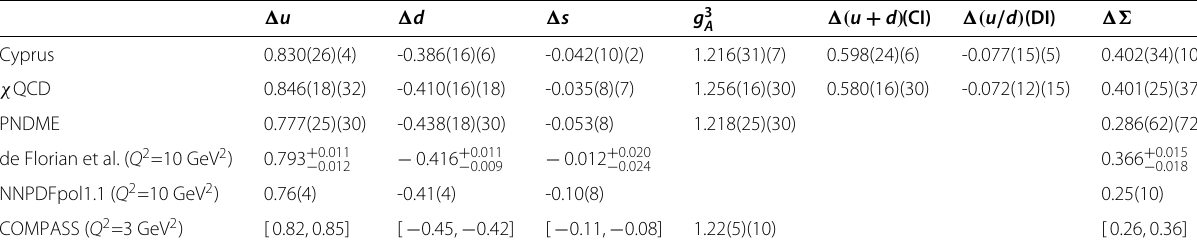
Table 1 Results of quark spin for the u , d and s flavors from three recent lattice calculations by the Cyprus group [41], χ QCD[42], and PNDME [43] in the MS scheme at 2 GeV are listed. (cid:2)( u + d ) (CI) and (cid:2)( u + d ) (DI) are the spins of the u and d quarks in the connected insertion(CI) and disconnected insertion(DI). Three analyses of experiments from de Florian et al. [5], NNPDF [6], and COMPASS [44] are also listed for